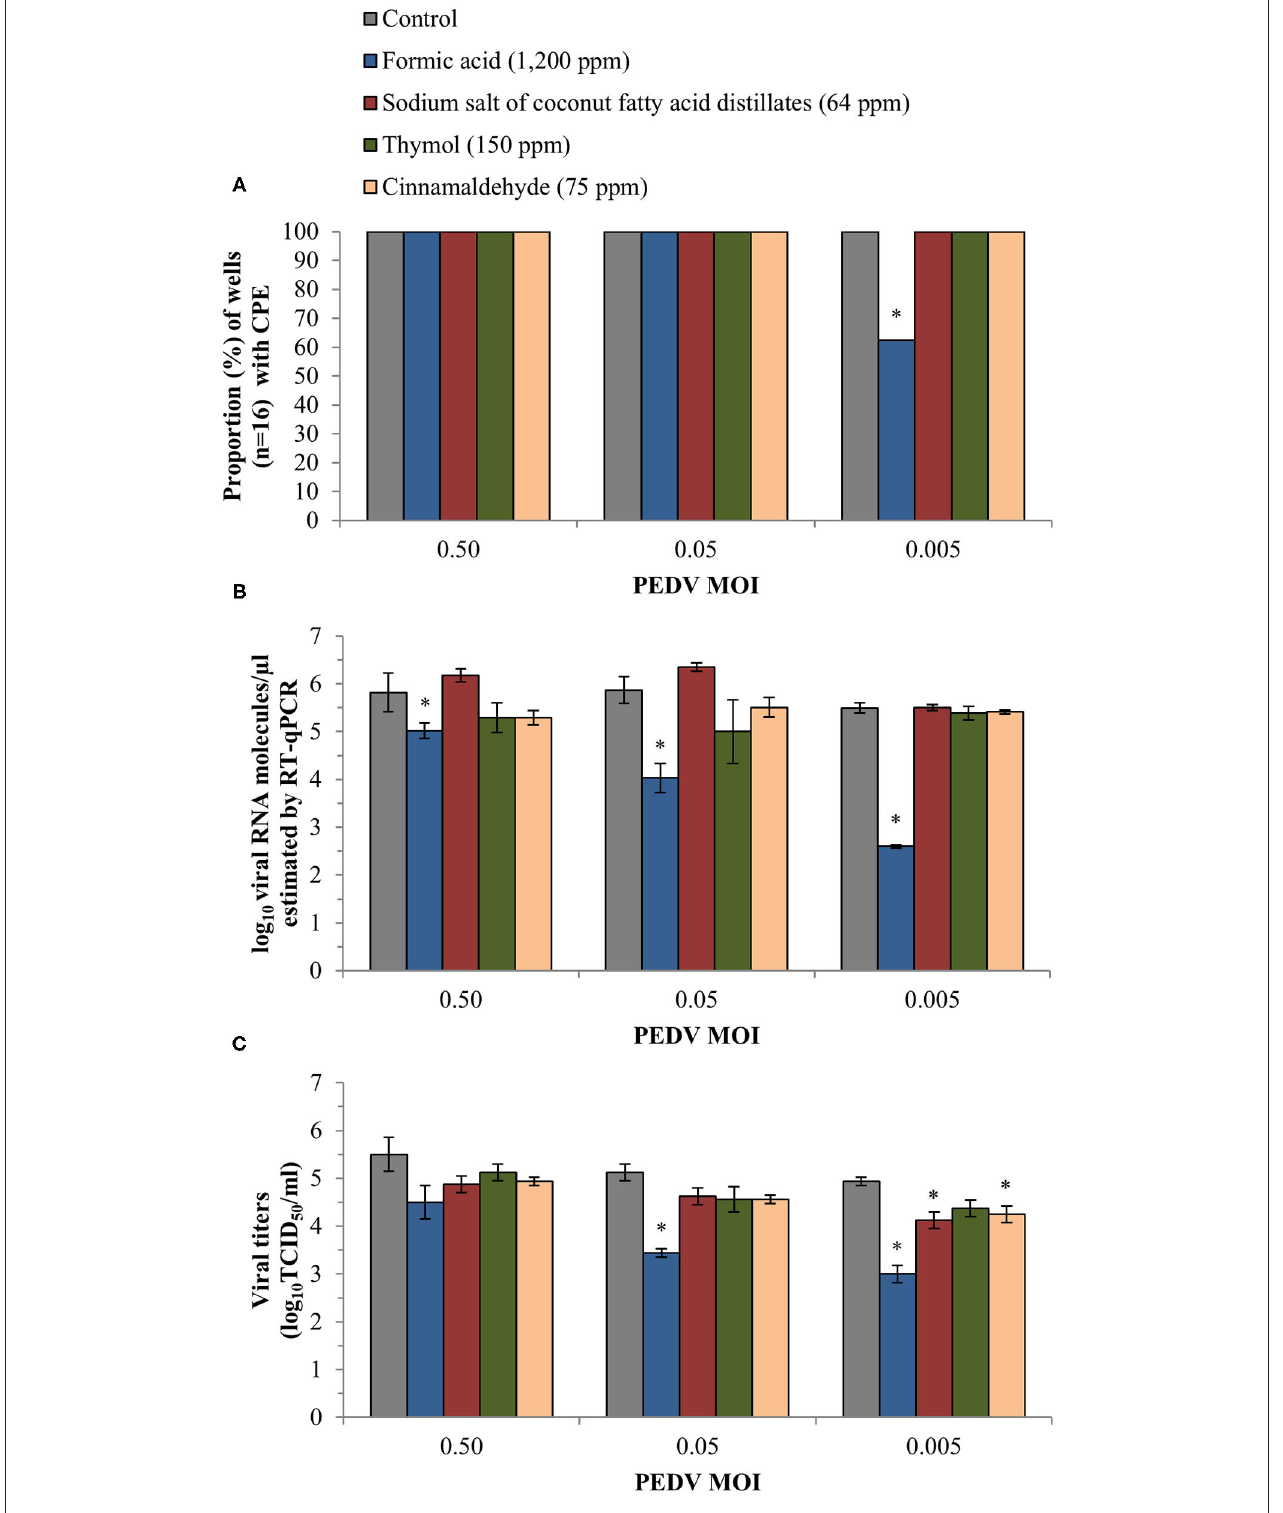
FIGURE 2 | Anti-PEDV activity of two organic acids, formic acid and sodium salt of coconut fatty acid distillates, and two single EO compounds, thymol and cinnamaldehyde, determined in Vero cells infected with three different PEDV MOIs. (A) Proportion (%) of wells ( n = 16) with CPE obtained after visual inspection of cells under an inverted light microscope. (B) Mean values ± standard deviations of log 10 viral RNA molecules/ µ l estimated using RT-qPCR. (C) Mean values ± standard deviations of viral titer expressed as log 10 TCID 50 /ml and calculated following the Reed and Muench method. *Statistically significant differences with respect to controls ( p <